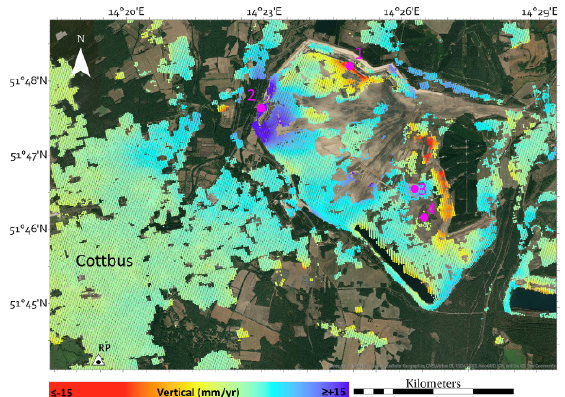
Figure 4. Mean vertical velocity map (17.03.2018 – 17.05.2019) in Cottbus, Germany. Top-right, open-pit mine owned by LEAG. Vertical movement converted from line-of-sight movement via trigonometry given no horizontal movement. Negative and positive, subsiding and uplifting. RP, reference point. Target points (TP) 1 – 4 selected for time-series analysis.